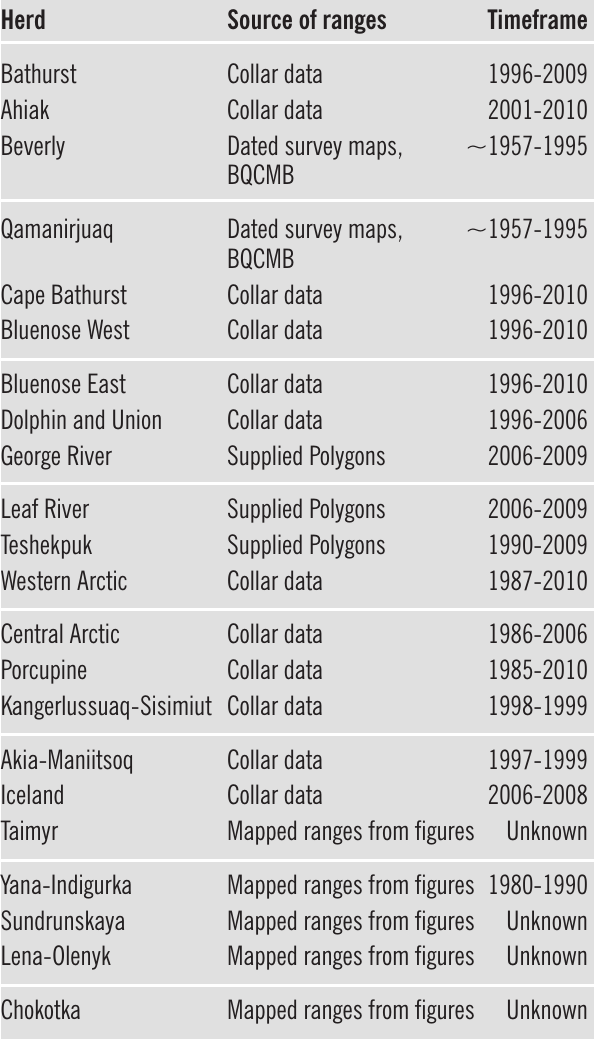
Table 1. The source of range information and time periods they represent for CARMA’s 22 migratory tundra